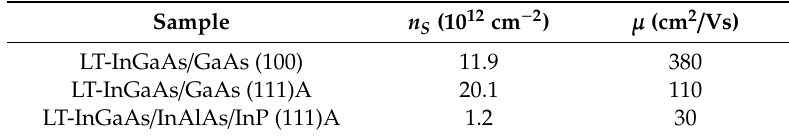
Table 1. Electronic mobility µ and sheet concentration n S in photoconductive heterostructures.